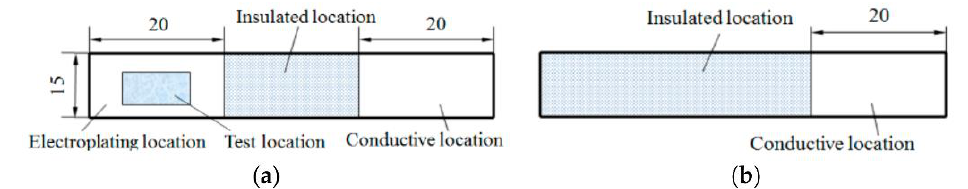
Figure 1. Q235A substrate specification diagram: ( a ) Electroplated surface and ( b ) nonelectroplated surface